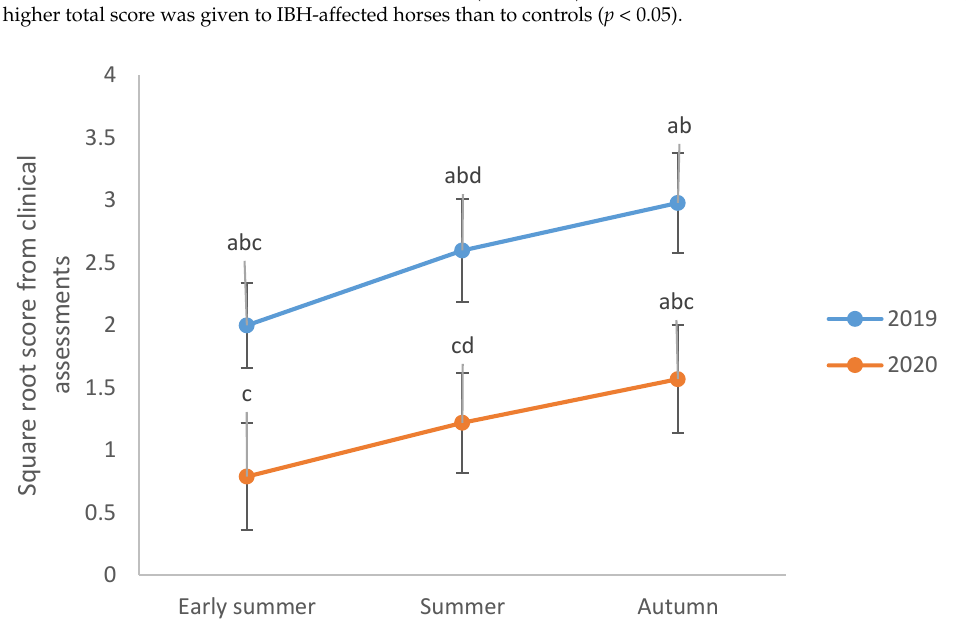
Different superscripts indicate significant differences between seasons ( p < 0.05) analysed from square-root- transformed data of scores from clinical assessments (not shown). For horses assessed in both 2019 and 2020, a higher total score was given to IBH-affected horses than to controls ( p < 0.05).